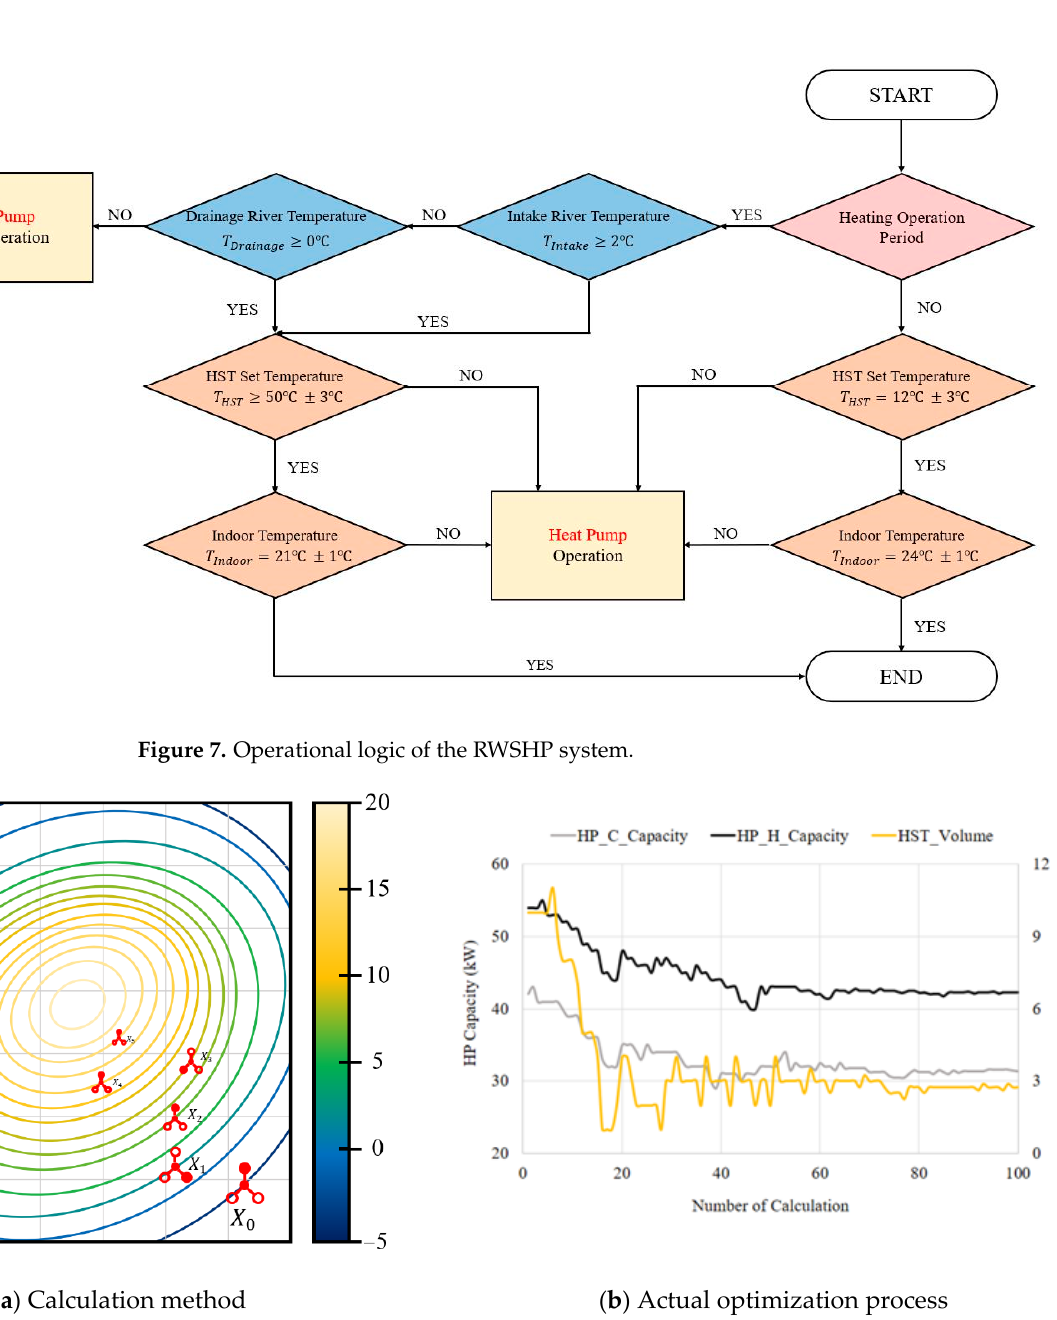
Figure 8. Hooke-Jeeves algorithm calculation method and actual optimization process; ( a ) calculation method of the Hooke – Jeeves algorithms, ( b ) actual optimization process according to the objective function.